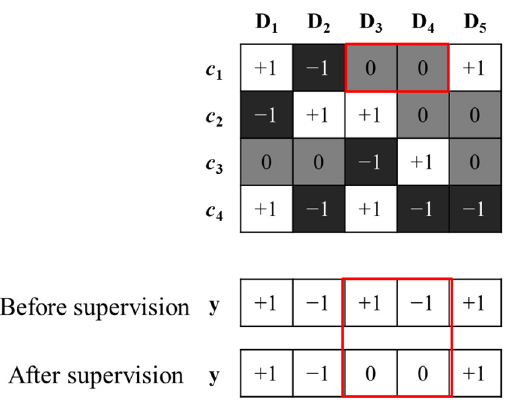
Figure 6. The output code of test sample supervised by SM-ECOC-V1 in the decoding process.